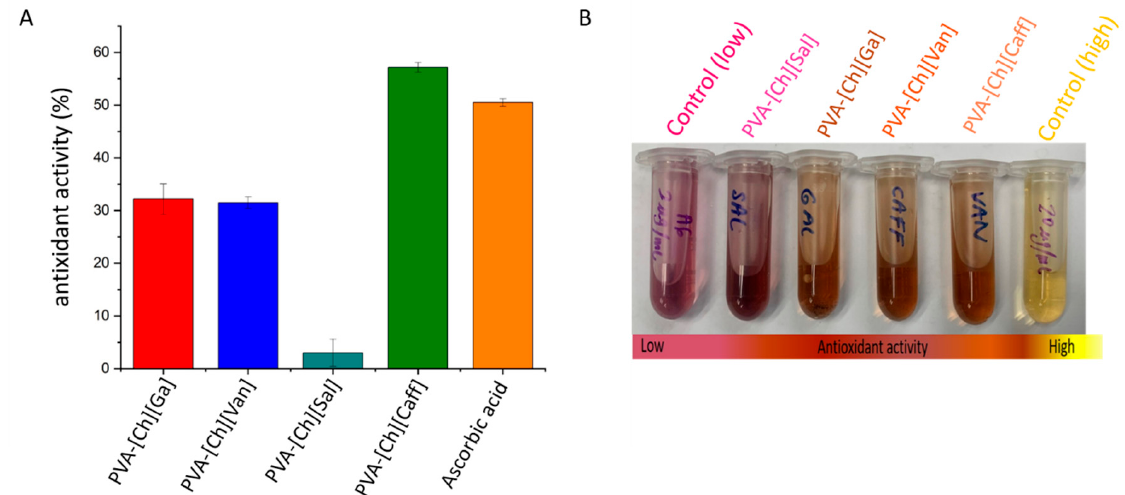
Figure 6. ( A ) Antioxidant activity of iongels quantified as the inhibition percentage of the DPPH radical via in chemico at 200 µ g/ µ L. ( B ) Picture showing the color change of each polyphenol iongel radical via in chemico at 200 µg/µL. ( B ) Picture showing the color change of each polyphenol iongel and controls with DPPH reagent after 120 and controls with DPPH reagent after 120 min.